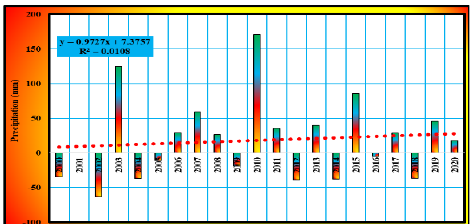
Figure 3: Represents Annual Total Rainfall Trend Line in Ghotki district 2000-2020